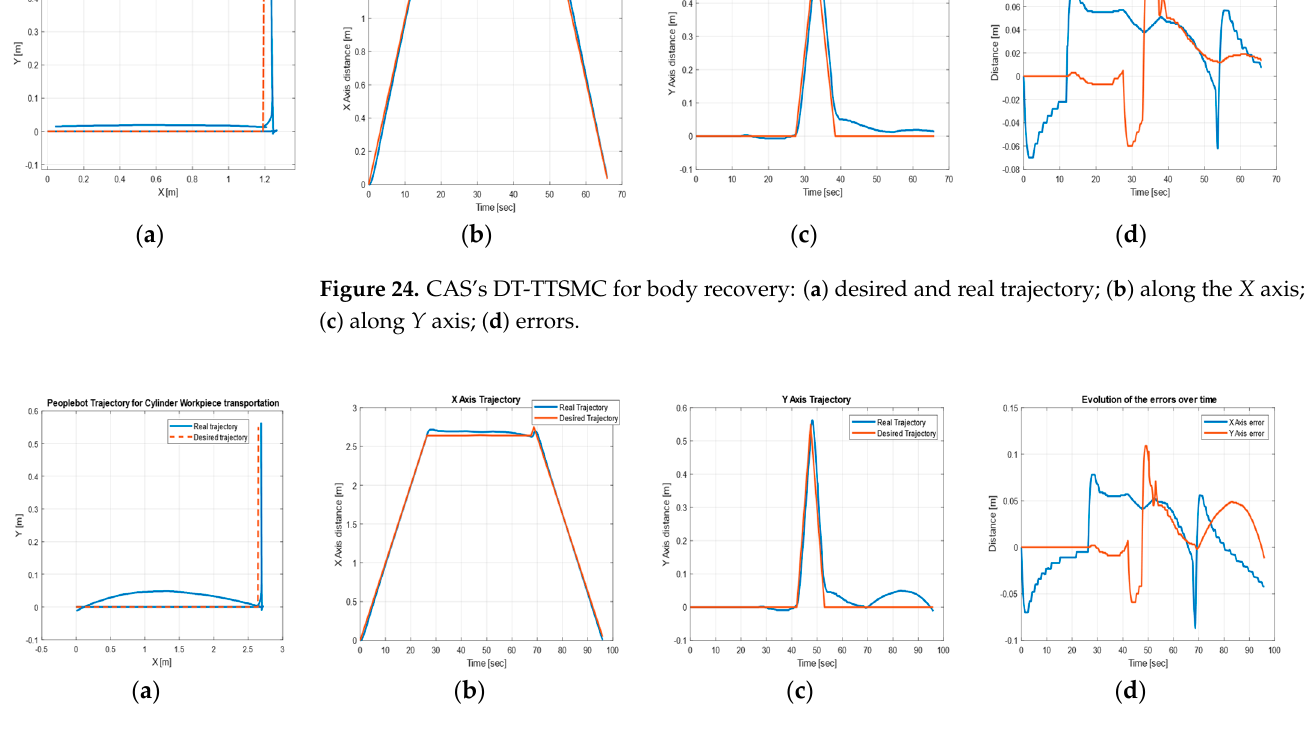
( d ) Figure 24. CAS’s DT-TTSMC for cylinder recovery: ( a ) desired and real trajectory; ( b ) along the X